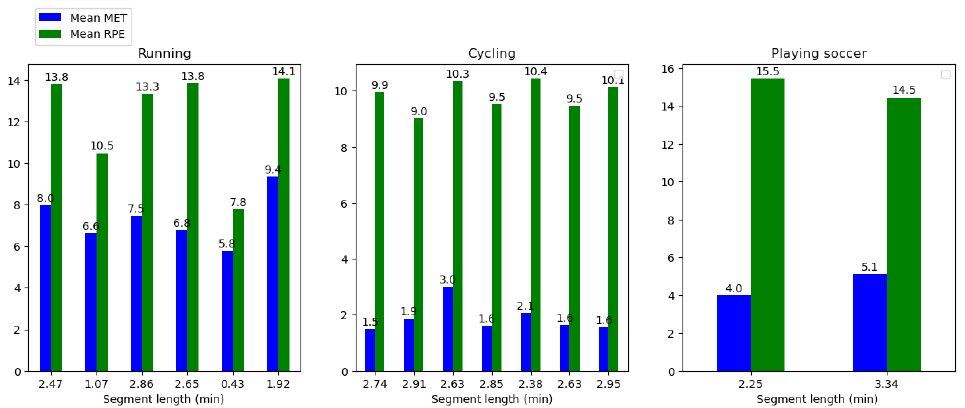
Figure 10. Predicted MET and RPE per sport on